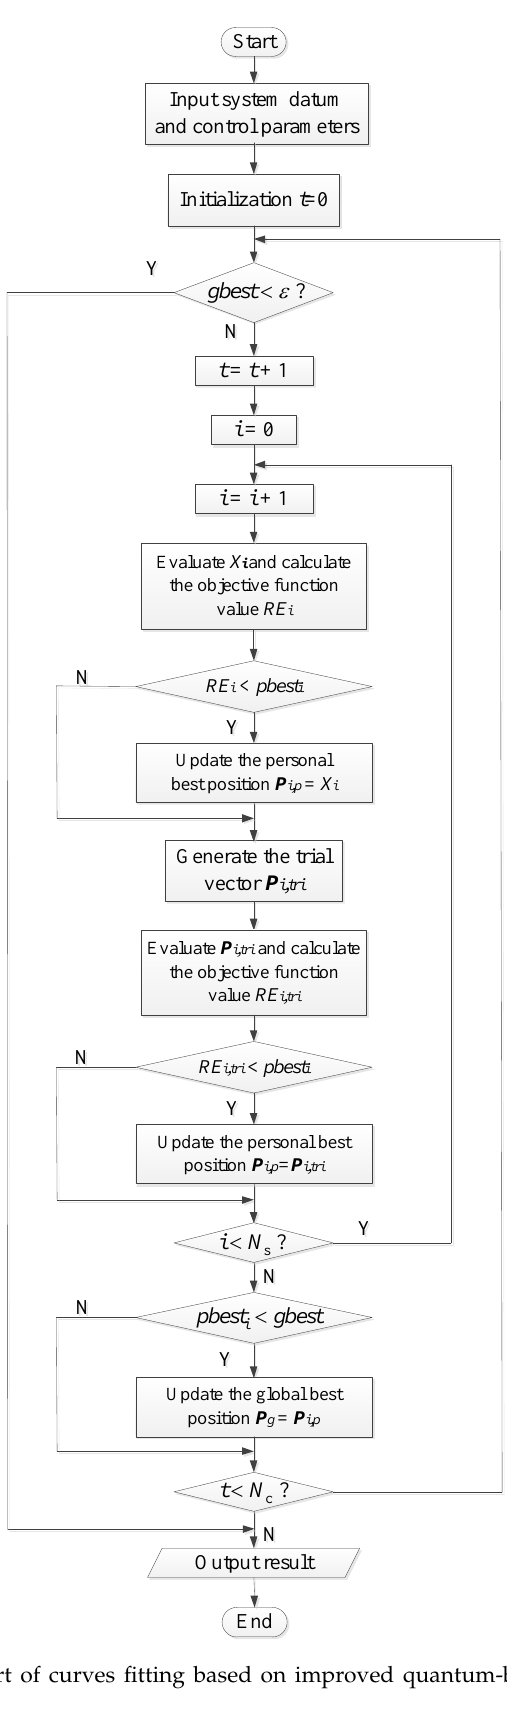
Figure 4. The flow chart of curves fitting based on improved quantum-behaved particle swarm optimization.